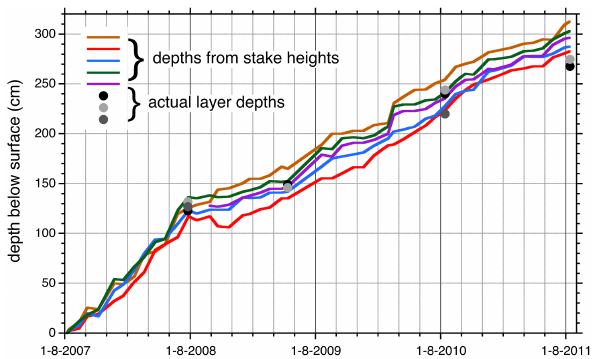
Figure 2. The depth of the enriched snow layer as a function of time, based on measuring the height of each of the five poles that mark the field (lines), together with the points indicating the actual depth of the enriched layer as revealed by the isotope measurements later in the lab (two to three points per year).